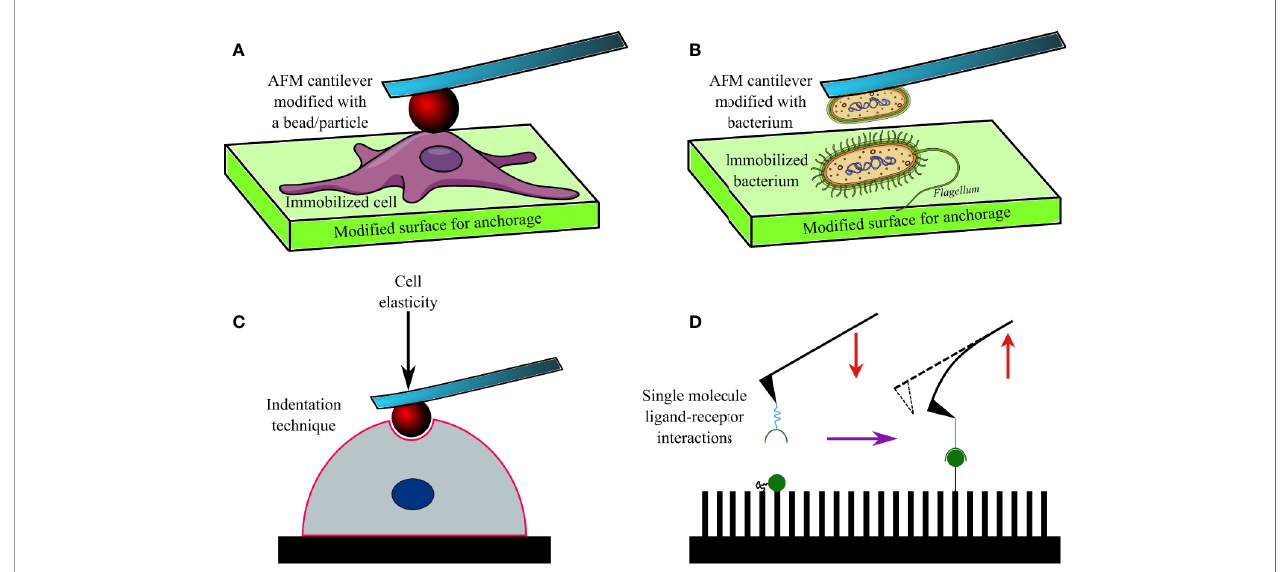
FIGURE 2 | A diagram showing an AFM cantilever modi fi ed with a bead (A) , and bacterium (B) to perform indentation studies (C) on an immobilized cell or bacterium. Modi fi ed AFM tips are also used to investigate various ligand-receptor interactions (D) on functionalized